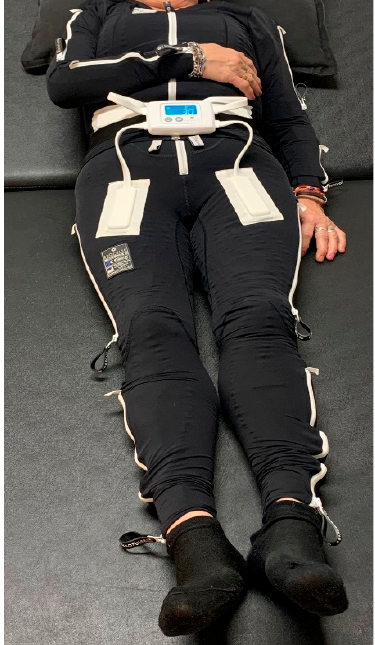
Figure 1. EXOPULSE Mollii Suit [30].